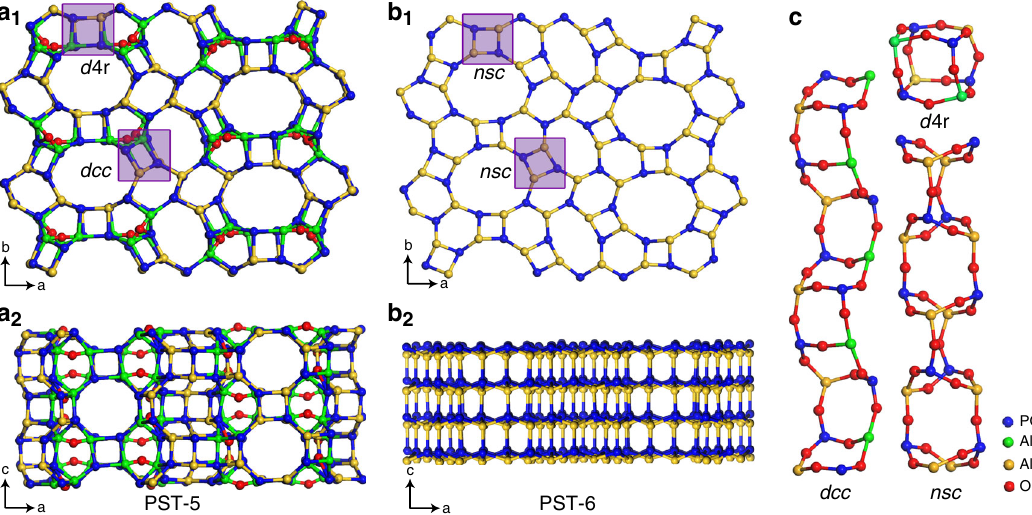
Fig. 2 Comparison of the structures of PST-5 and PST-6. Structural models of PST-5 ( a 1 ) and PST-6 ( b 1 ) viewed along the c -axis. Both structures are built from the same building layer containing 4-, 6-, 8-, and 10-rings (if the OH groups, shown in red are not considered). The difference is the orientations of the (Al,P)O 4 tetrahedra in the two structures. The red atoms in ( a 1 ) correspond to the OH groups bridging two Al atoms in PST-5. These Al atoms are fi ve- coordinated. Structural models of PST-5 ( a 2 ) and PST-6 ( b 2 ) viewed along the b -axis, showing the transforms of double-crankshaft chains ( dcc ) and double- 4-rings ( d 4 r ) in PST-5 ( a 1 ) to narsarsukite-type chains ( nsc ) in PST-6 (indicated by purple boxes). c Building units in PST-5 ( dcc and d 4 r ) and PST-6 ( nsc